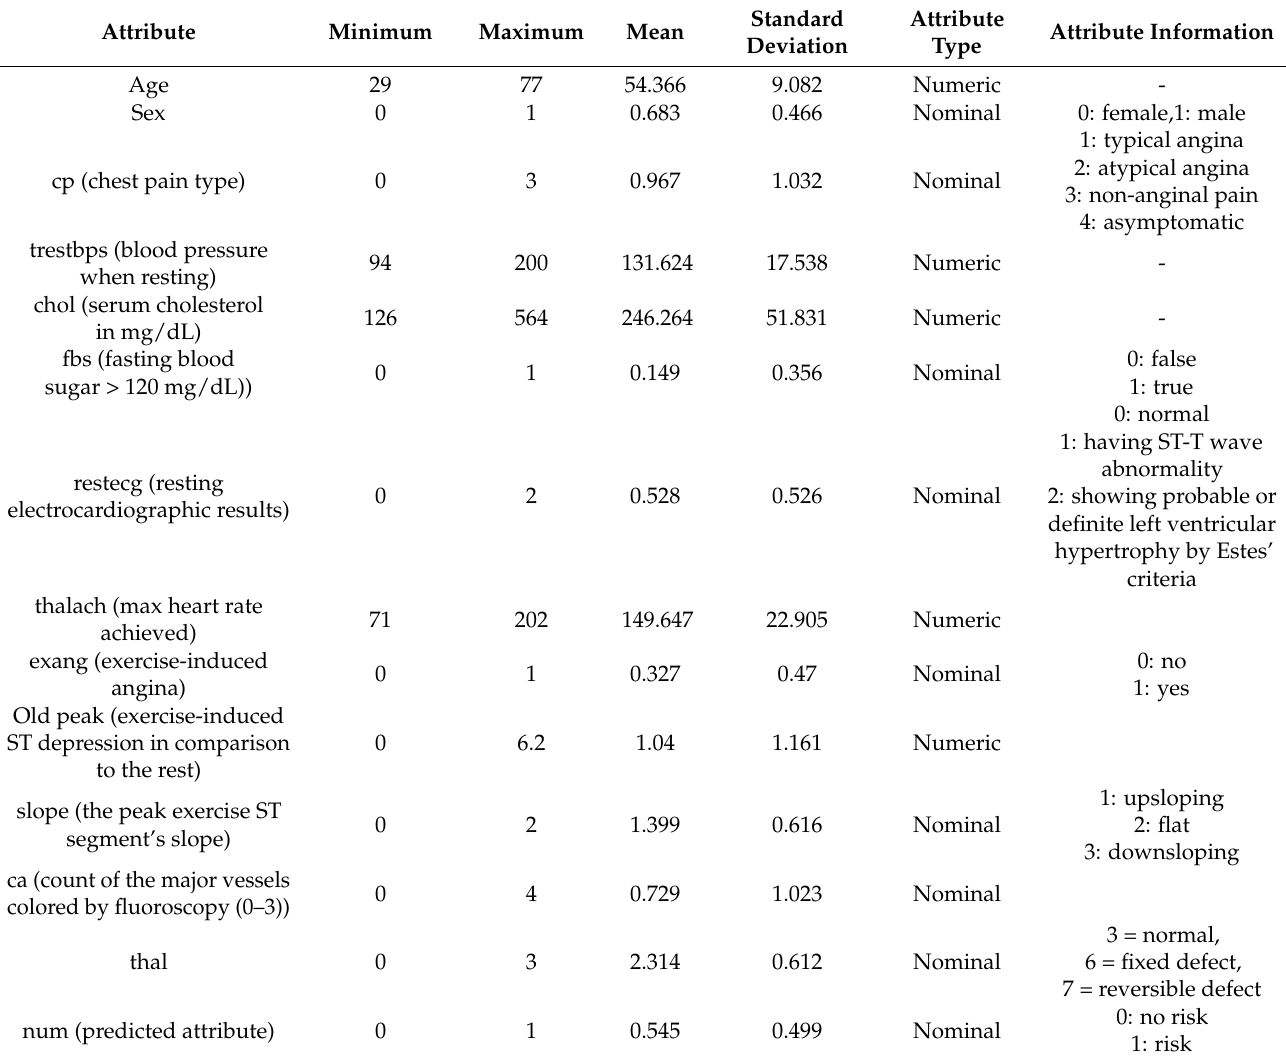
Table 3. The statistical value of the feature sets and their